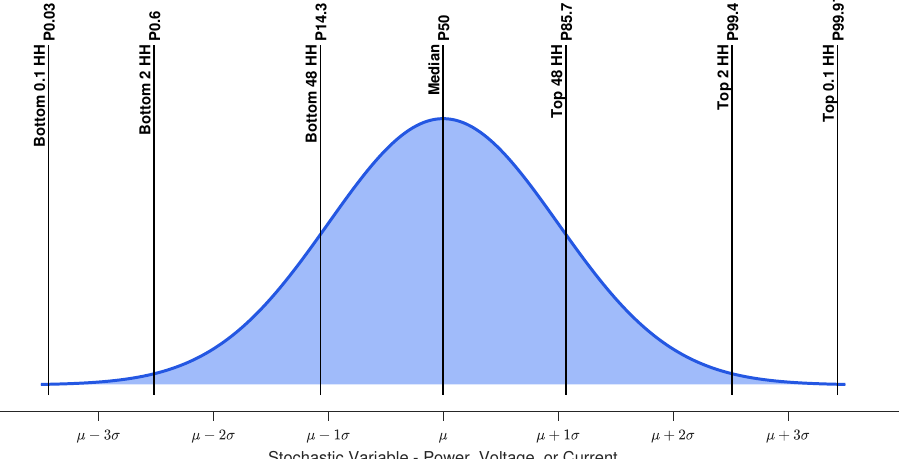
Figure 5. Relationship between half-hours out of a week and percentile values shown for a nor- mal distribution.